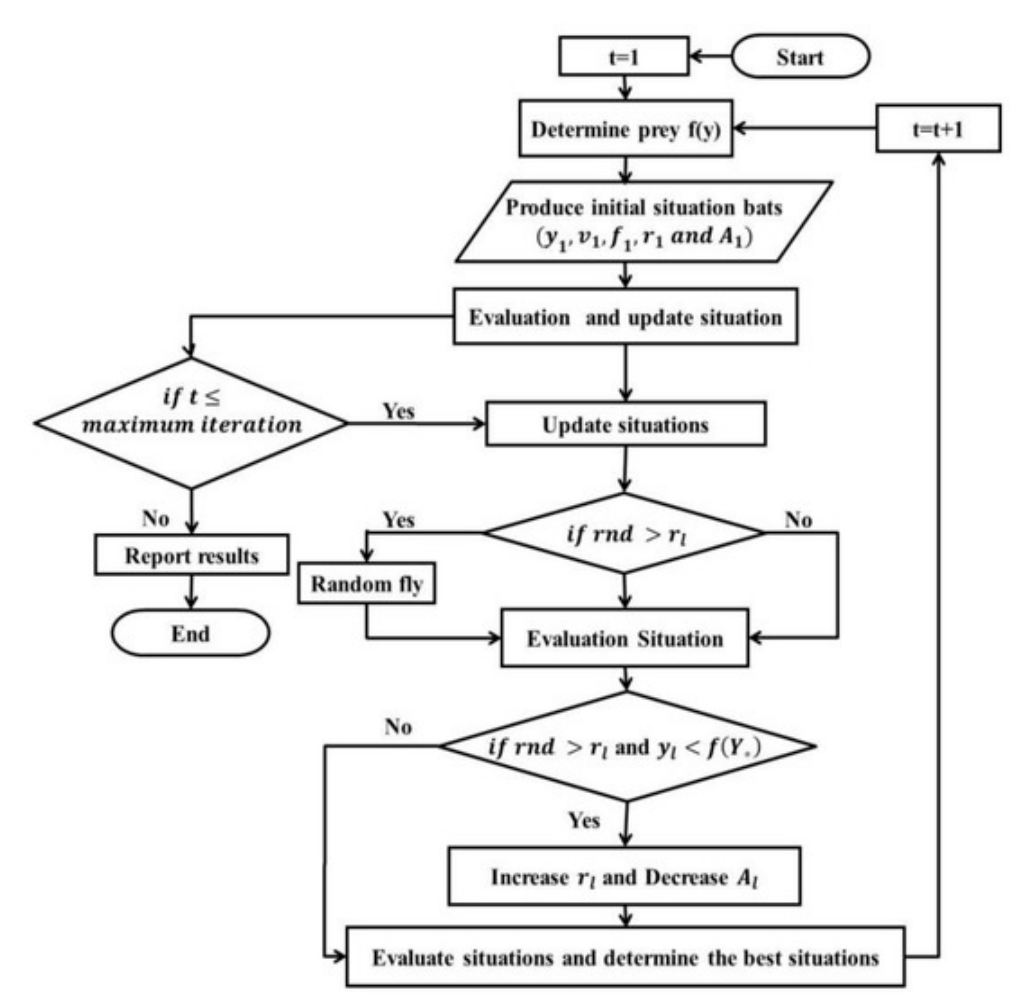
Figure 3. Bat algorithm (BA) process.